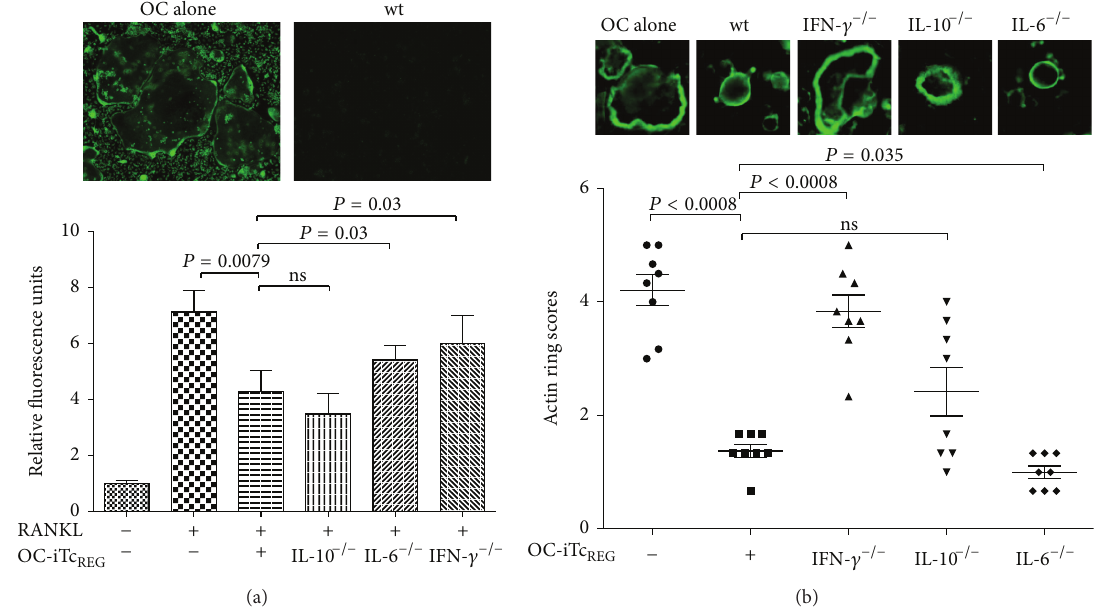
Figure 2: OC-iTc REG suppress osteoclast differentiation and actin ring formation: (a) OC-iTc REG were generated from polyclonal wt, IL-10 −/− , IL-6 −/− , or IFN- 𝛾 −/− splenic T cells and cocultured with osteoclast precursors in the presence of RANKL and M-CSF for 5 days. The T cells were then removed and the adherent cells were assayed for TRAP activity using a fluorescent substrate ELF97. IFN- 𝛾 and IL-6 were found to be necessary for OC-iTc REG anti-osteoclastogenic activity. (b) Osteoclasts are differentiated on bovine bone slices and then cultured for 24 hrs with wt, IL-10 −/− , IL-6 −/− , or IFN- 𝛾 −/− OC-iTc REG . The T cells were then removed and the osteoclasts were stained with fluorophore- conjugated phalloidin to assay for actin ring formation. IFN- 𝛾 was shown to be required for the OC-iTc REG to suppress actin ring